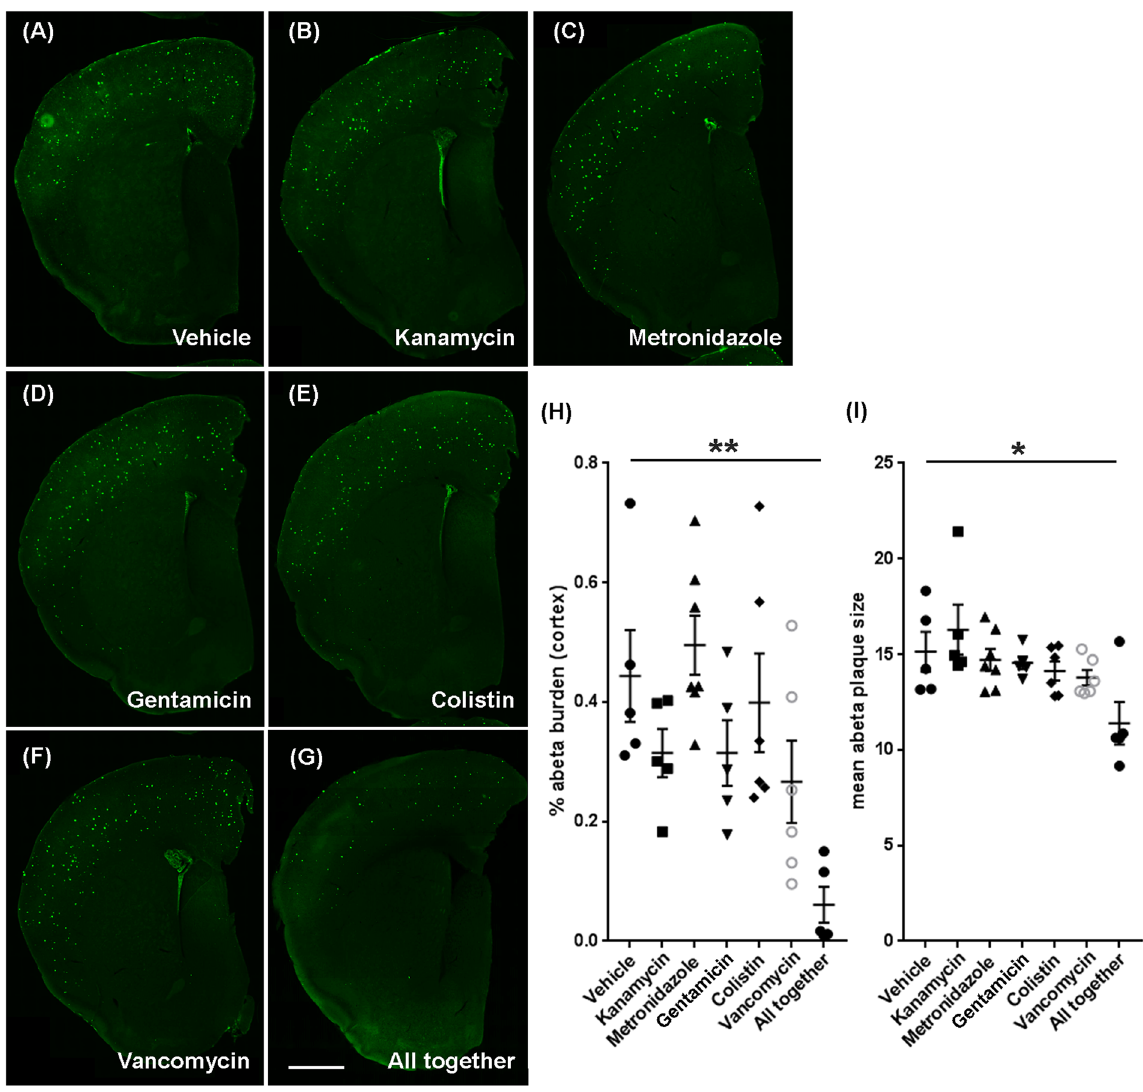
Figure 2. Reduced A β pathology was specific to the ABX-cocktail (all together)-treated male mice at 9 weeks of age. Representative images of A β plaque burden in the Vehicle ( A ), kanamycin ( B ), metronidazole ( C ), gentamicin ( D ), colistin ( E ), vancomycin ( F ), and ABX-cocktail (all together) ( G ) treated male mice using 3D6 antibody. ( H ) A β burden ( P = 0.0012) and ( I ) A β plaque size ( P = 0.0146) was significantly lower in ABX- cocktail (all together) treated male mice (One-way ANOVA: A β burden: F(6, 32) = 5.276, P = 0.0007; A β plaque size: F(6, 32) = 3.394, P = 0.0105), while individual ABX-treated mice showed no significant differences ( P > 0.05). Scale bar in panel g represents 1000 µ m and applies to all panels a-g. N = 5 control (vehicle), n = 5 kanamycin, n = 7 metronidazole, n = 5 gentamicin, n = 6 colistin, n = 6 vancomycin, n = 5 ABX cocktail- treated male mice. Data are mean ± SEM. * P < 0.05, ** P <